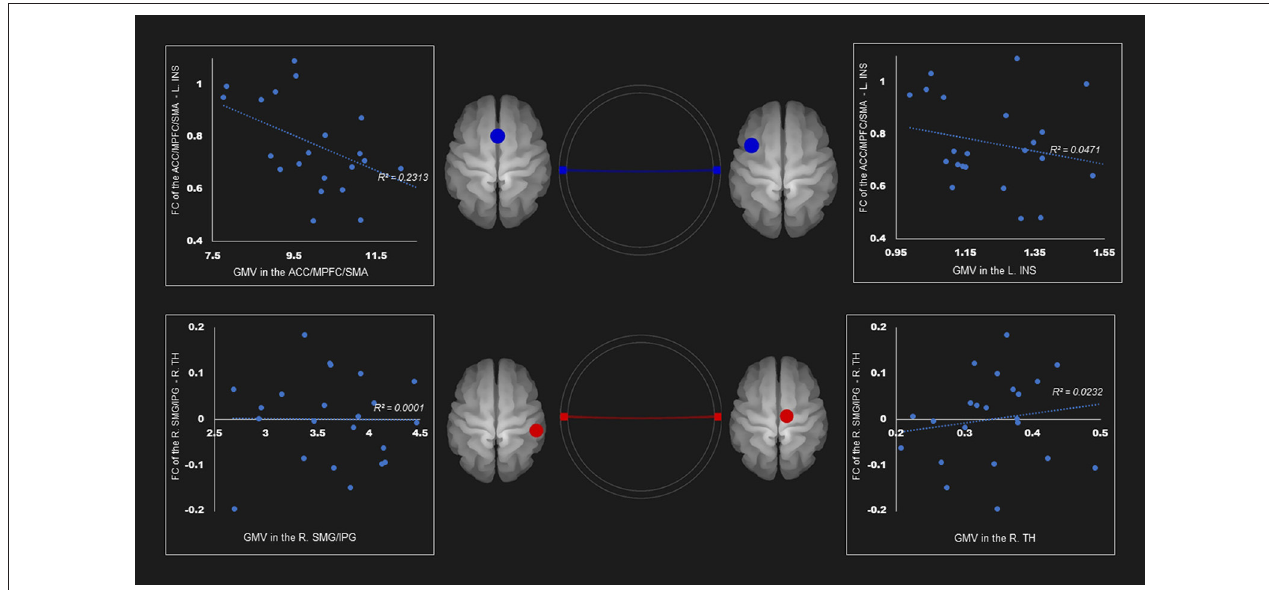
FIGURE 1 | Correlation between FC and gray matter volume in the salience network among AUD group. Gray matter volume of anterior cingulate gyrus/medial prefrontal cortex/supplementary motor area was negatively associated with the FC of the left insula—anterior cingulate gyrus/medial prefrontal cortex/supplementary motor area (r = − 0.48). Red and blue lines represent the positive and negative functional connectivity between ROIs, respectively. FC, functional connection; ACC, anterior cingulate cortex; AUD, alcohol use disorder group; INS, insula; L, left; MPFC, medial prefrontal cortex; R, right; SFG, superior frontal gyrus; TH, thalamus.